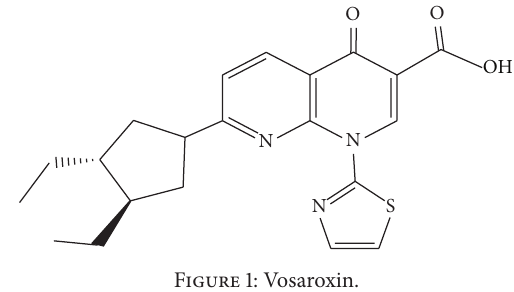
Figure 1: Vosaroxin.